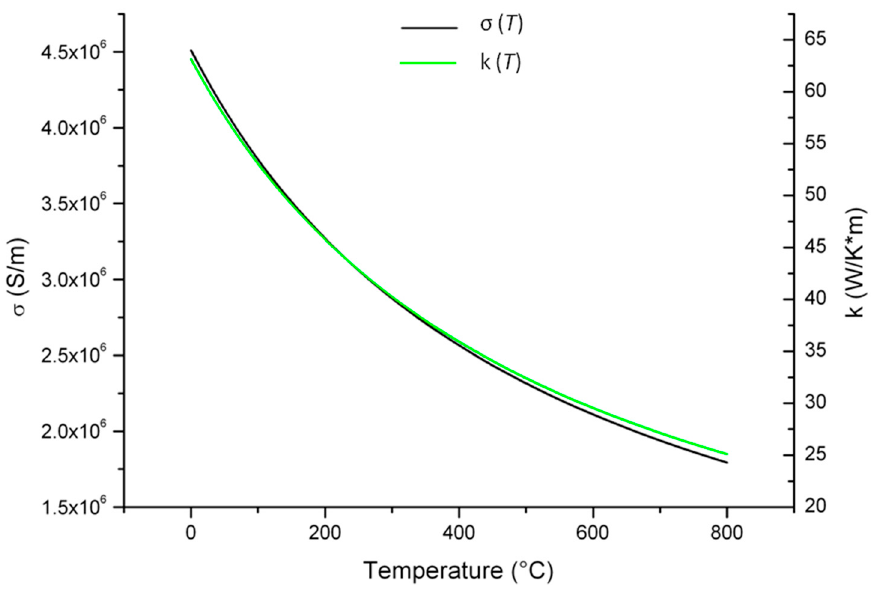
Figure 3. Electrical conductivity σ ( T ) and thermal conductivity k ( T ) of the Pt film used for simulations.